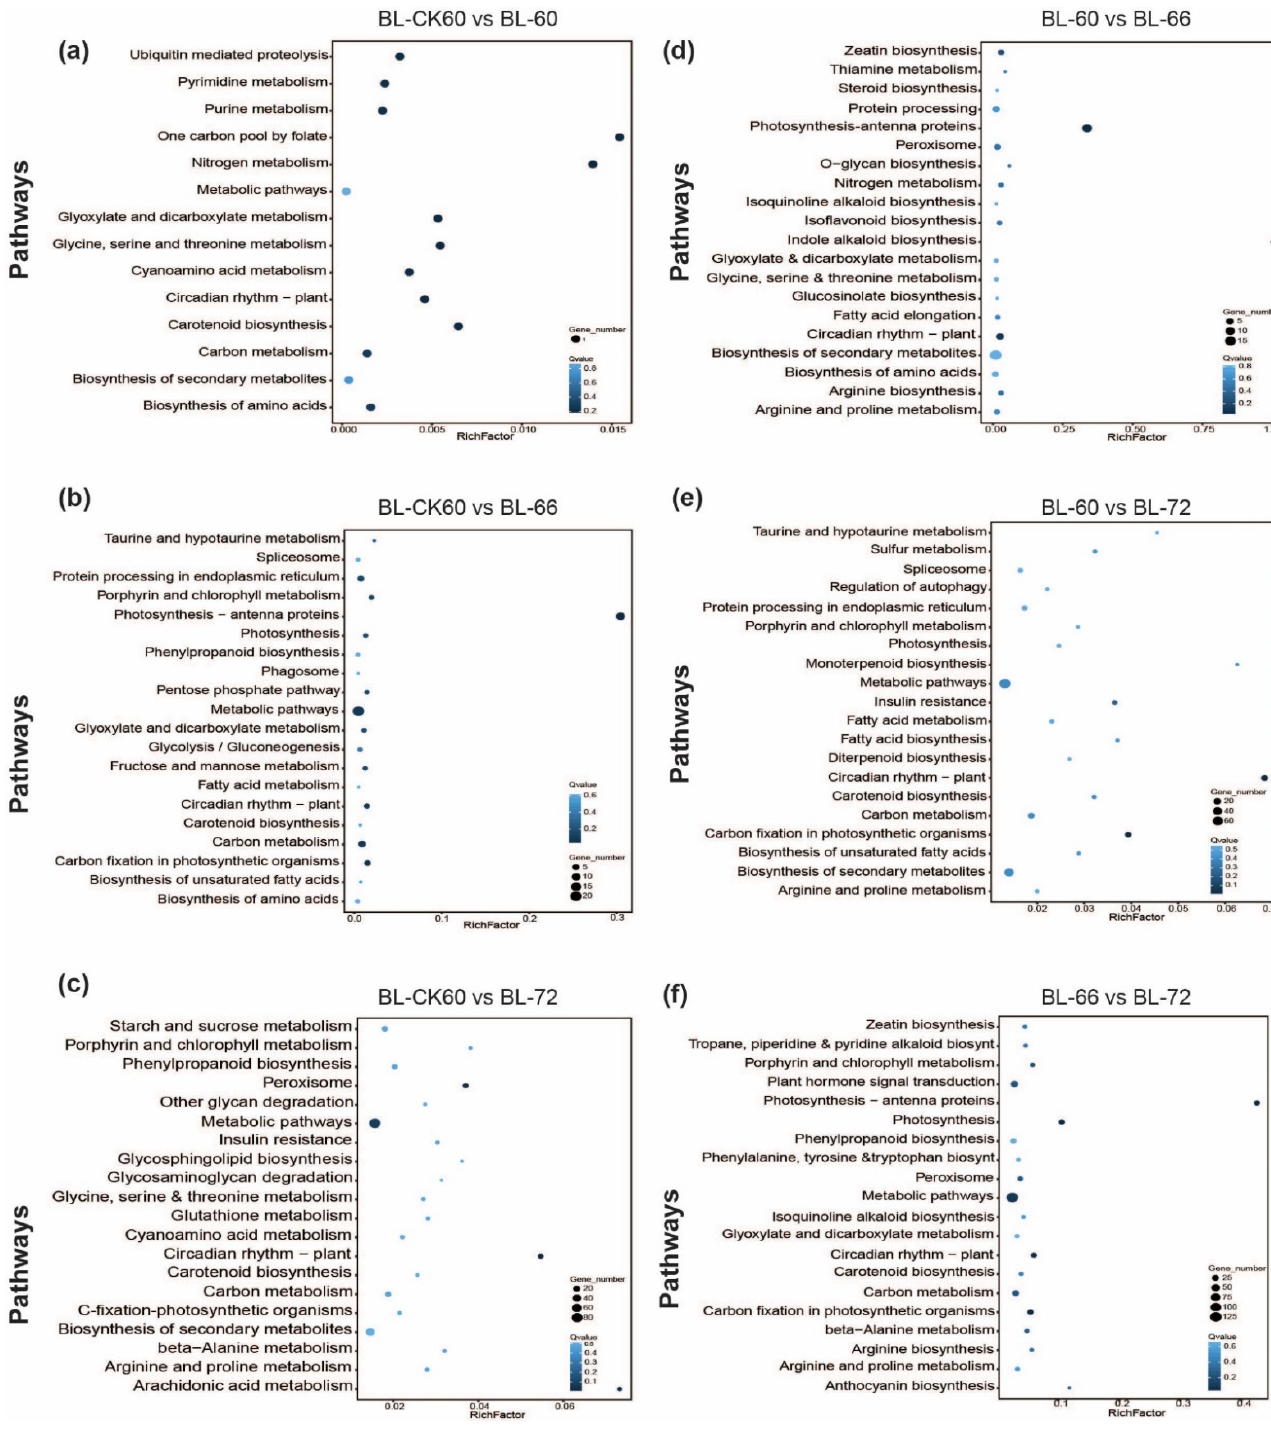
Figure 5. Top 20 KEGG pathway enrichments of DEGs between control and treatment and among treatments at three tested time points (60 h, 66 h, and 72 h); ( a – c ) Top 20 KEGG pathway enrichments of DEGs between control and treatment at tested time points (60 h, 66 h, 72 h); ( d – f ) Top 20 KEGG pathway enrichments of DEGs among treatment comparisons at tested time points (60 h, 66 h, and 72 h).